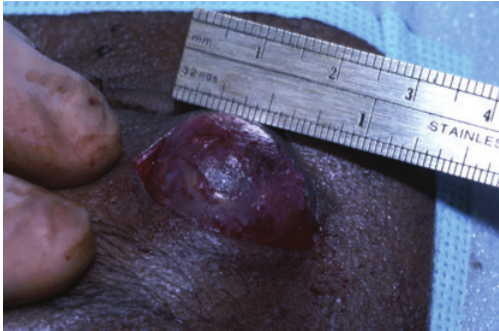
Figure 1: Mass at temporal orbital rim.